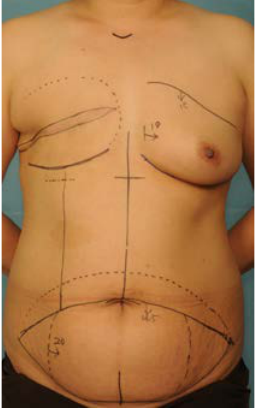
Figure 1. Design of ipsilateral pedicled TRAM flap for delayed breast reconstruction. On the breast side, the mastectomy scar was removed, the area to be dissected was marked with a dotted line, and the IMF line was drawn about 2 cm above the opposite side. On the abdomen, the upper incision was placed just above the upper border of the umbilicus, and an additional dotted line was drawn 4–5 cm above this line.